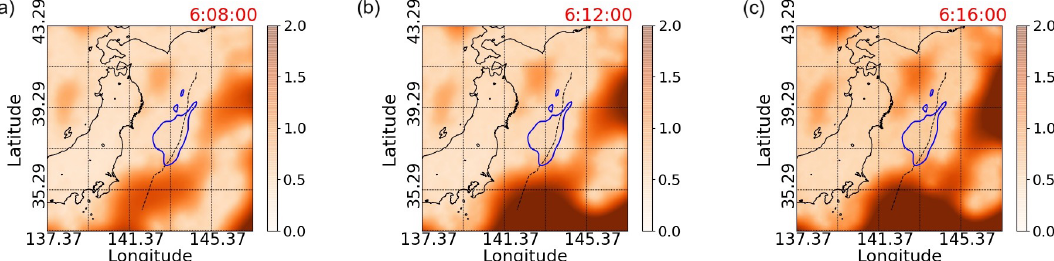
Figure 11. Uncertainty of the estimated TEC values at 06:08:00, 06:12:00, and 06:16:00. The uncertainty in this case is defined as 3 times the standard deviation. The area surrounded by the blue line is the simulated initial tsunami by inversion analysis with 130 small basis functions implemented by T. Saito et al. (2011). The black dashed line indicates the location of the axis of the Japan